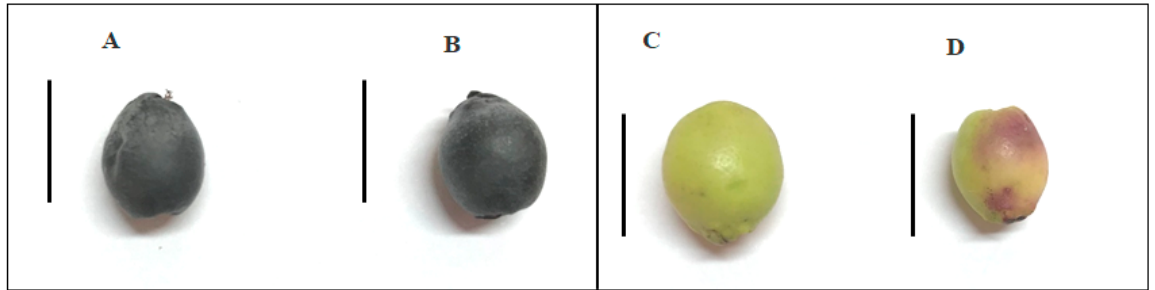
Figure 5. ( A ) “Giovanna” berry cultivar at 150 DAF; ( B ) “Giovanna” berry cultivar at 180 DAF; ( C ) “Grazia” berry cultivar at 150 DAF; ( D ) “Grazia” berry cultivar at 180 DAF. Scale bar equals 1 cm.